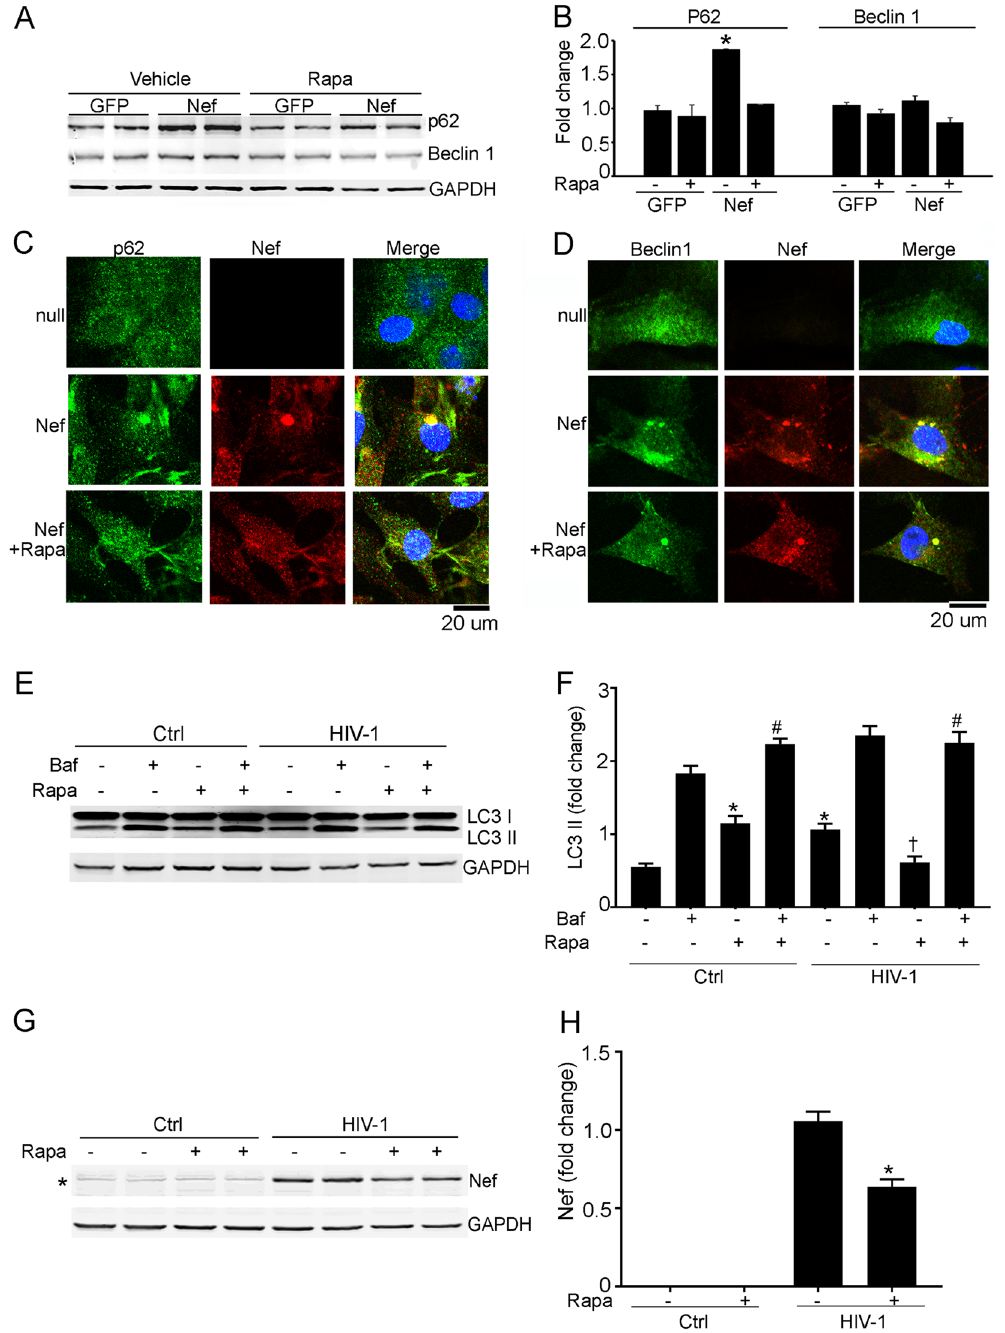
Figure 8. Rapamycin treatment reduced the level of aggregates in Nef-expressing cardiomyocytes. ( A , B ) Western blot shows that rapamycin restores the level of p62 in Nef-expressing cardiomyocytes. NRVCs were transduced with Ad-Nef or Ad-GFP for 48 hours and cells were treated with rapamycin for 12 hours before isolation of proteins (n = 6/group, * P < 0.05, significant difference between Ad-GFP and Ad-Nef). ( C , D ) Rapamycin treatment reduced the aggregate level of p62 and Beclin 1 in cardiomyocytes. NRVCs were transduced with Ad-Nef or Ad-null for 48 hours and cells were fixed with 4% PFA. Fixed cells were stained with p62 and Beclin 1 antibody. ( E , F ) Rapamycin treatment improved the autophagic flux of HIV-1-treated cardiomyocytes. Western blot showed expression of LC3-II in cardiomyocytes after rapamycin treatment. NRVCs were treated with pseudotyped HIV-1 for 5 days and also treated with rapamycin for 12 hours. Autophagy flux was determined using the autophagy inhibitor bafilomycin (n = 6/group, * P < 0.05, vs Ctrl; † P < 0.05, vs HIV-1, # P < 0.05, vs Ctrl treated bafilomycin). ( G , H ) Rapamycin treatment reduced the level of Nef protein in the cardiomyocytes. NRVCs were treated with HIV-1 for 5 days and also with rapamycin for 12 hours. Expression of Nef protein was determined by Western blot with Nef antibody (n = 6/group, * P < 0.05, significant difference between HIV-1 and HIV-1 treated with rapamycin). ( * Indicates a nonspecific band in Western blot with Nef antibody in the HIV infected